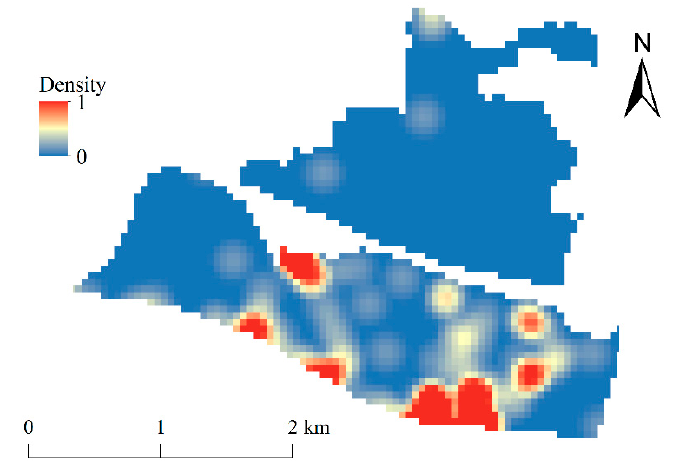
Figure 4. The spatial distribution of the potential offenders in the XT police district (11 September 2017 to 3 December 2017).